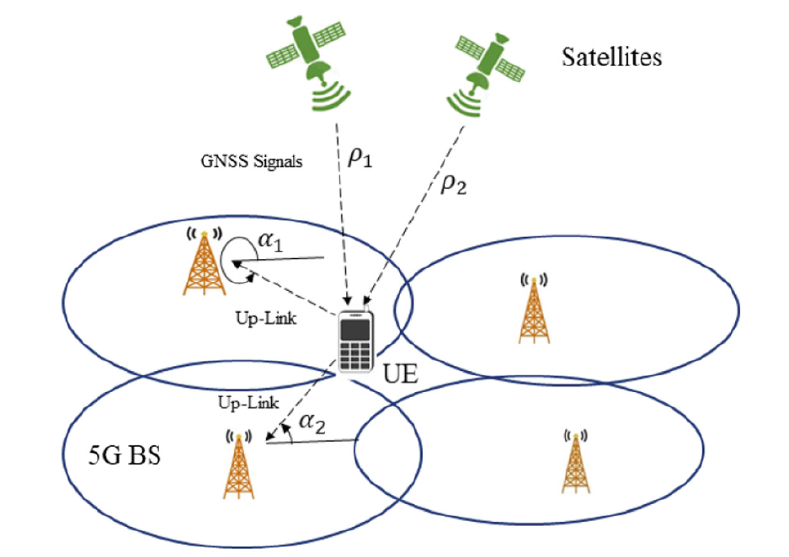
Figure 5. Illustration of the hybrid GNSS-5G positioning